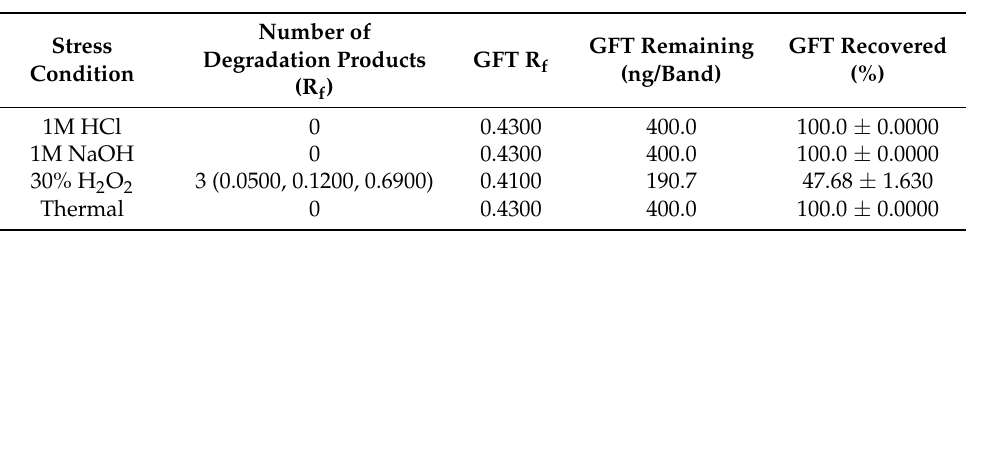
Table 7. Results of forced-degradation assessment of GFT at various stress conditions for the greener HPTLC method (mean ± SD; n =